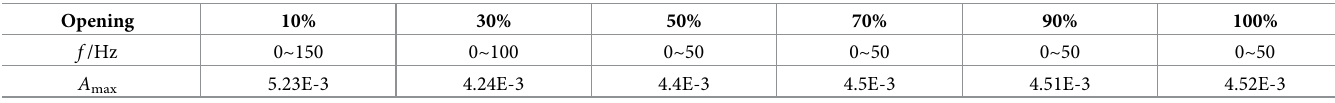
Table 3. Frequency domain characteristics of the lift coefficient.